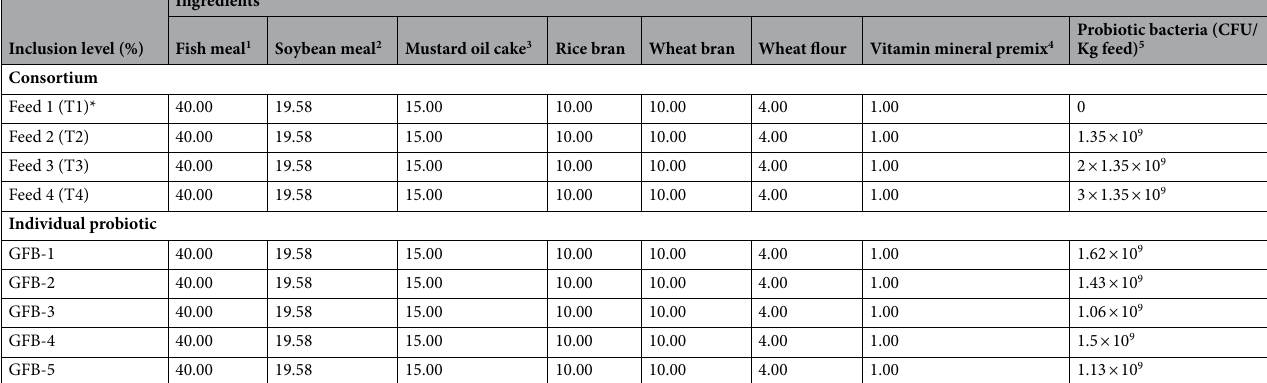
5.0. After incubating 1, 2, and 4 h and serial decimal dilutions in sterile PBS were prepared for determining the total viable cell number. The experiment was repeated twice and each reading shows the mean of three observa- tions. Gastrointestinal juices were prepared fresh by dissolving pepsin (Thermo Fisher, USA) from B. gonionotus stomach mucosa (3 g l −1 ) in sterilized saline solution (5 g l −1 ) followed by Charteris et al. 25 . Subsequently, the pH